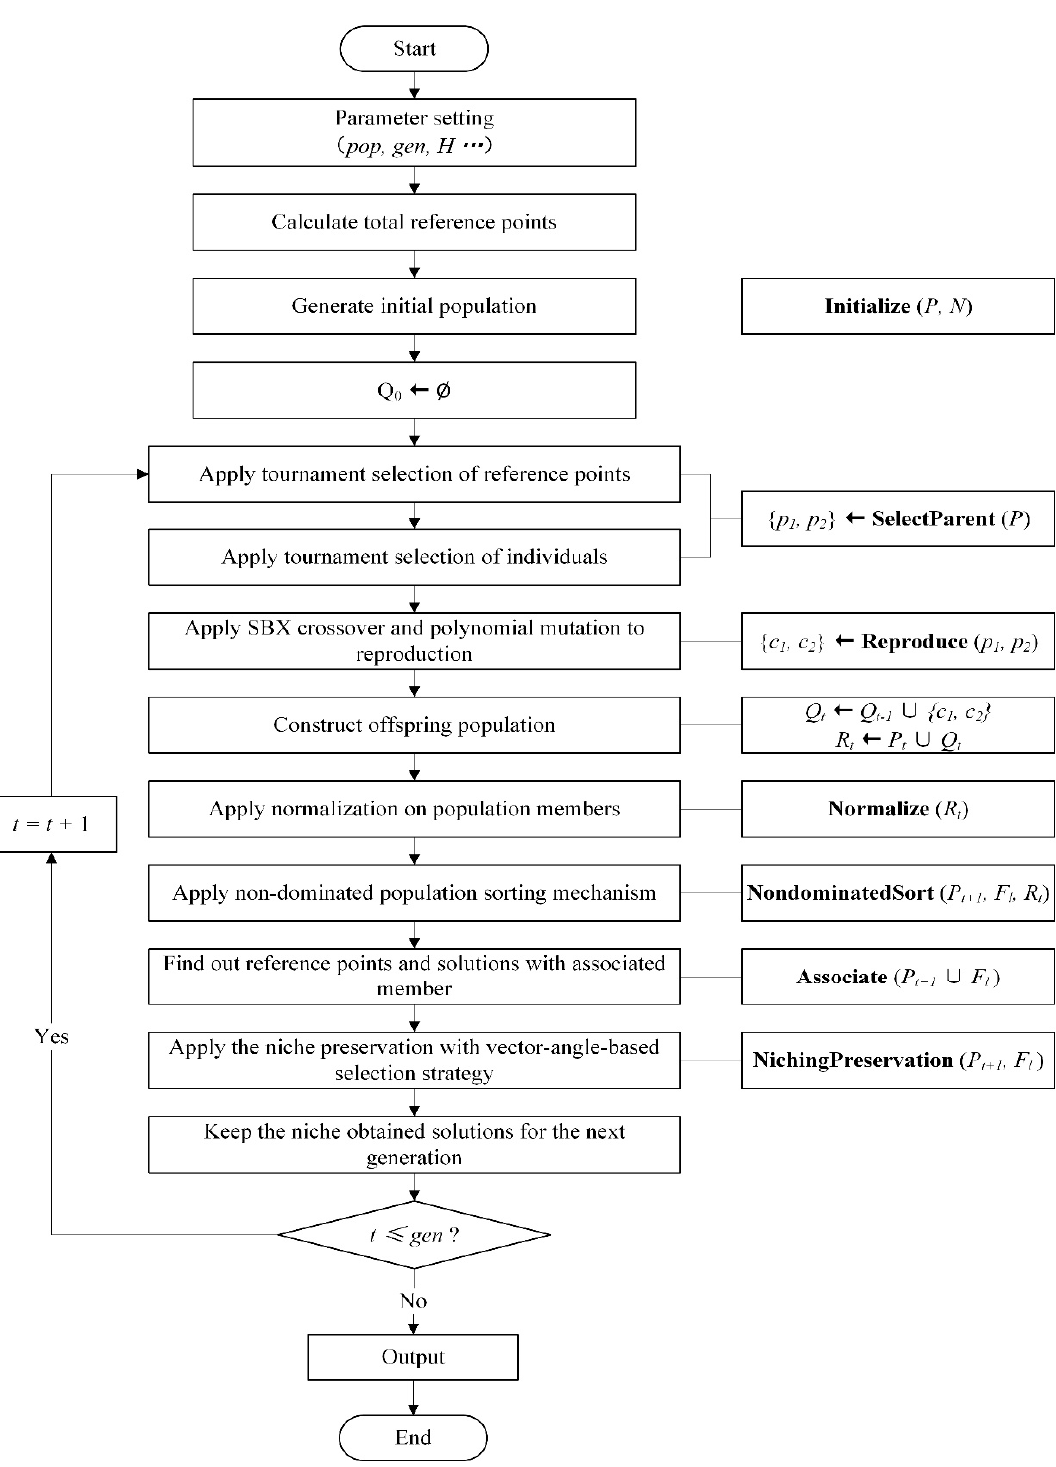
Figure 3. The flow chart of VA-NSGA-III.